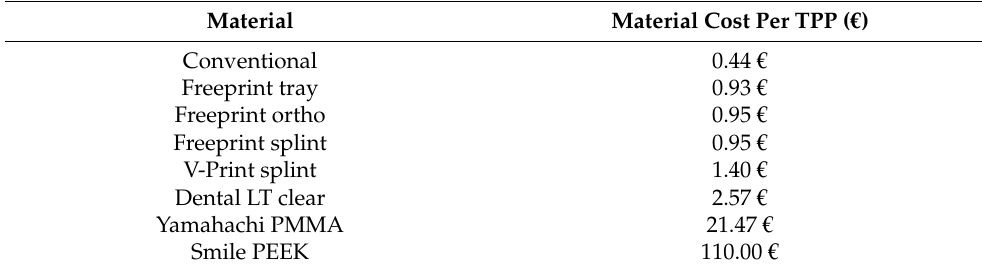
Table 2. Material costs per TPP (without wire) lowest to